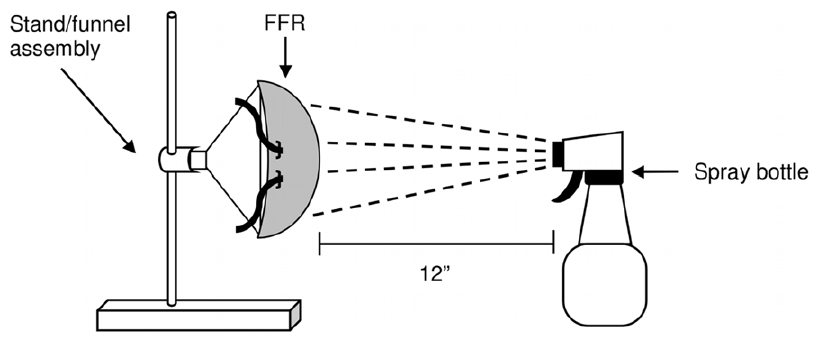
Figure 3. Schematic of the droplet loading method.